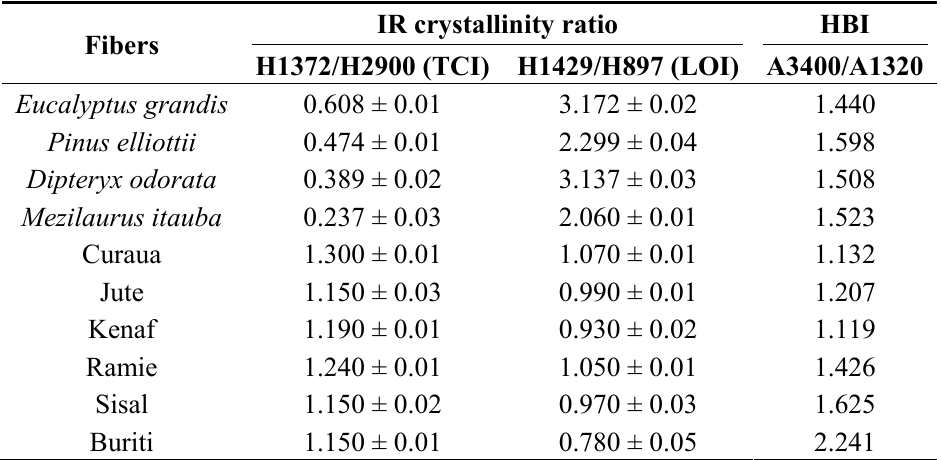
Table 3. Infrared crystallinity ratio and hydrogen bond intensity of the fibers studied. HBI, hydrogen bond